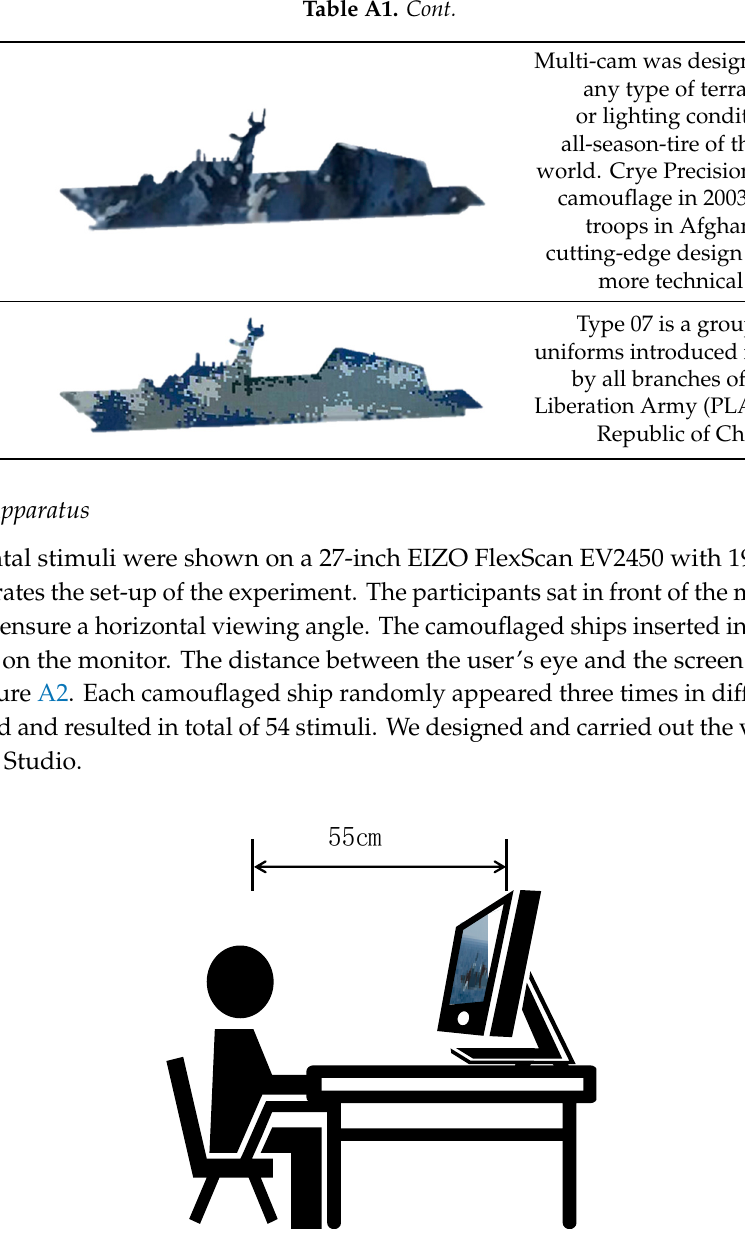
( c ) Figure A1 . Background with different condition, ( a ) calm; ( b ) sparkling; ( c ) rough. Appendix A.2. Camouflage Collection Six commonly used camouflage patterns were obtained from a Web search. Because the design concept of navy uniform camouflage is the same as that of military weapons and equipment and seeks to maximize concealment, these six camouflage patterns were designed to be shaped in the form of a ship, using Adobe Photoshop CS6, as shown and introduced in Table A1. Table A1. Six camouflage types. Type Camouflage Pattern Design Description MTP